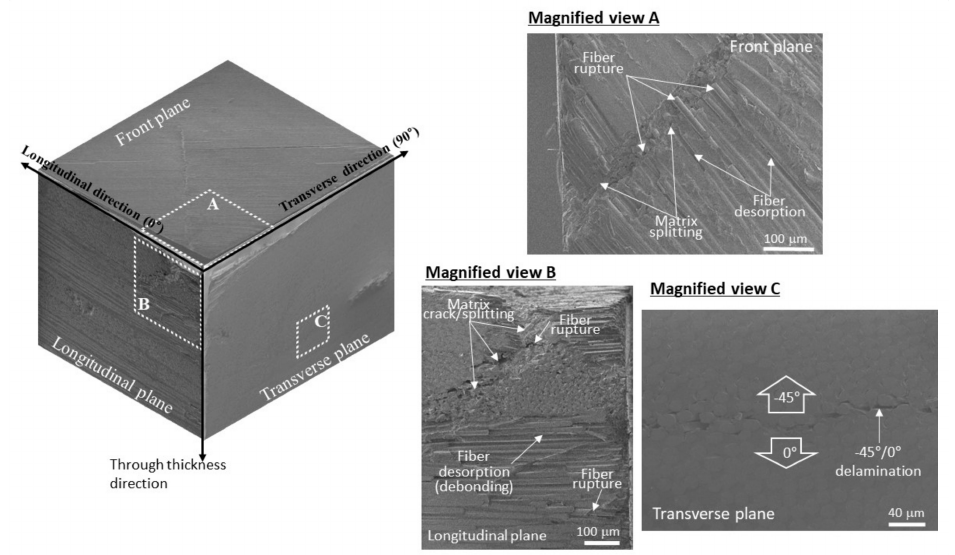
Figure 5. Typical impact damage patterns created by a pyramidal impactor for TRI laminate (at impact energy level of 8